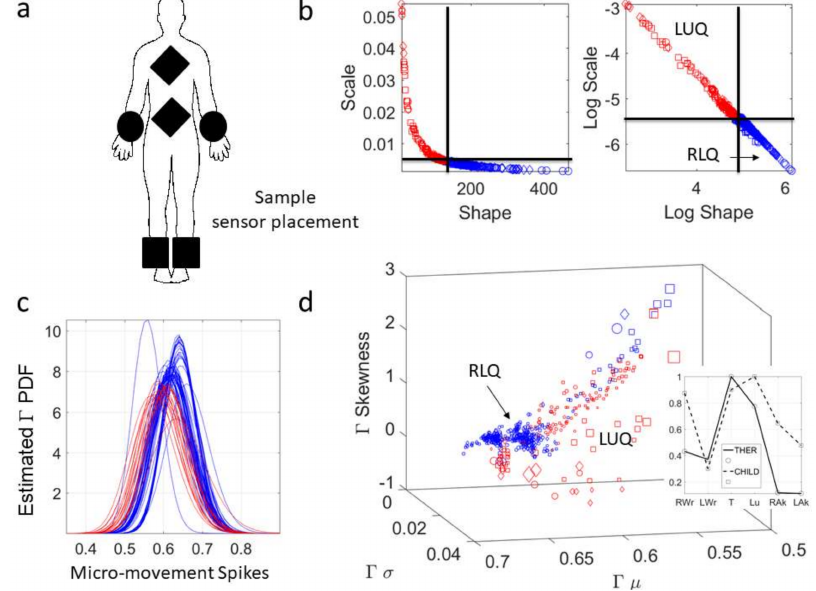
Figure A1. Criteria offered by the statistical platform for individualized behavioral analyses (SPIBA) and the micro-movements spike data type. ( a ) Generic sensor placement across the body (in this case wearable accelerometers were used synchronously and registering data for 60 min at 128 Hz